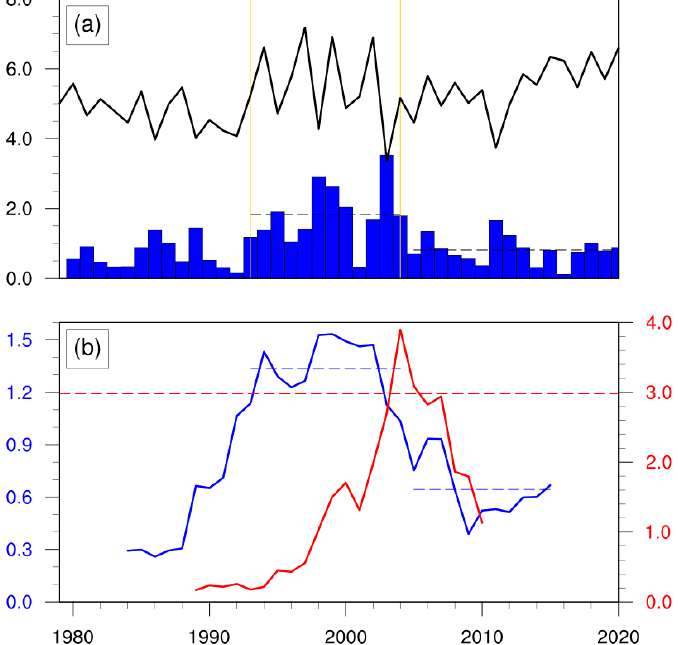
Figure 1. ( a ) Time series (black solid line) and interannual difference (blue bars) of summertime precipitation over SC. ( b ) F -test values (red solid line) and 11-year running standard deviations (blue solid lines) of summertime precipitation over SC (black dashed lines in ( a ) are averaged values of interannual variability in S1 and S2, respectively; blue dashed lines in ( b ) are averaged values of running standard deviation in S1 and S2, respectively; the red dashed line in ( b ) denotes the significant value exceeding the 95% confidence level; unit: mm d − 1 ).